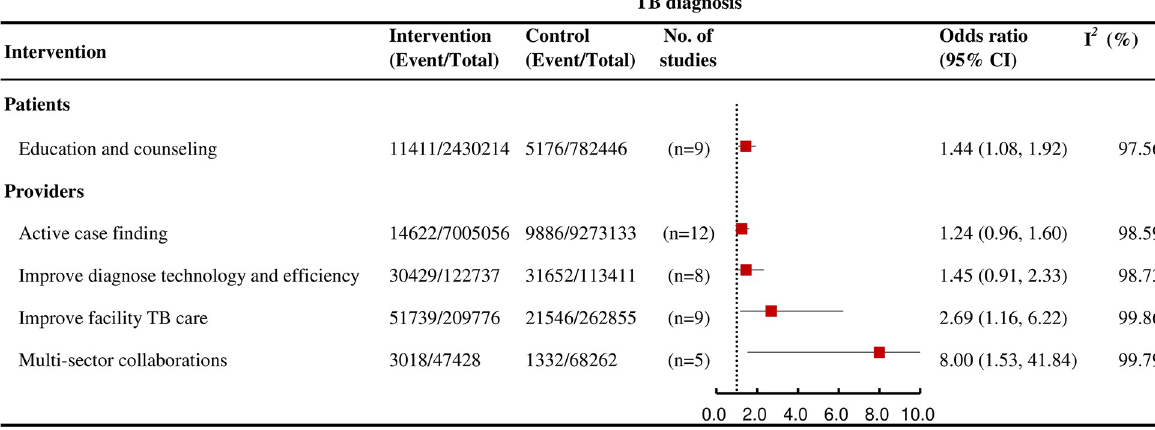
Fig 4. Forest plots showing the effects of various interventions on TB diagnosis outcomes for active TB.